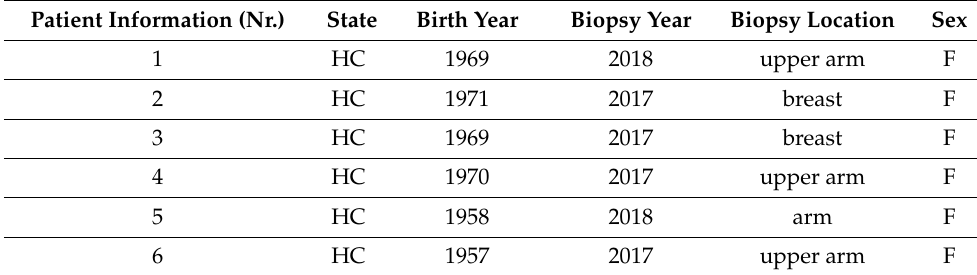
Table 1. Patient characteristics. HC = healthy control, F = female. Patient Information (Nr.) State Birth Year Biopsy Year Biopsy